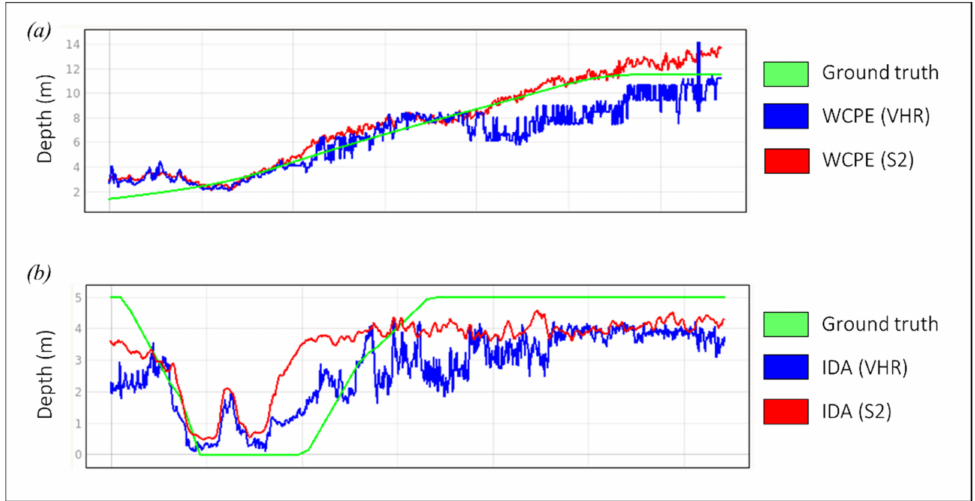
Figure 32. Typical cross sections comparing methods and satellite images of different resolutions. ( a ) VHR best single image vs Sentinel-2 time series modellised with WCPE, ( b ) The same, modellised with traditional SDB. Note the VHR poor signal/noise